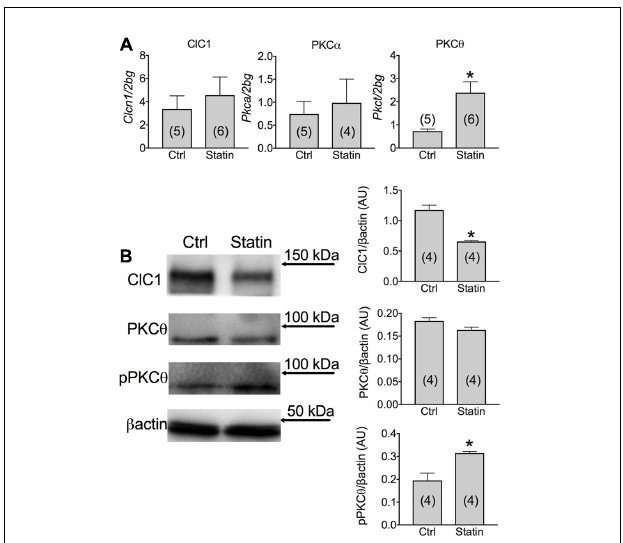
FIGURE 3 | (A) Real-time PCR analysis of mRNA expression level of ClC-1 chloride channel and of PKC α and PKC θ in VL muscle biopsies of patients in therapy with statin showing sign of myopathy. Histograms show quantification of transcript levels normalized by the beta-2 microglobulin gene. Mean values ± SEM in myopathic subjects (Statin) were compared with those of untreated subjects (Ctrl). ∗ Significantly different with respect to the own control ( P < 0.05 or less) by Student’s t -test. (B) Representative Western blot showing the expression levels of ClC-1 and PKC θ proteins in the unphosphorylated and phosphorylated form in muscle tissues. The blots were reacted with specific antibodies. β -actin was used to normalize the blot. The densitometric analysis of each experimental band was performed using ImageLab software. Histograms show quantification of relative protein levels. Relative intensity was calculated by normalization of the absolute intensity of target protein with the absolute intensity of β -actin, as reference standard, and are represented as arbitrary units (AU). Each bar represents the mean ± SEM from the number of muscle biopsies as indicated. ∗ Significantly different with respect to Ctrl (at least P < 0.05) by Student’s t